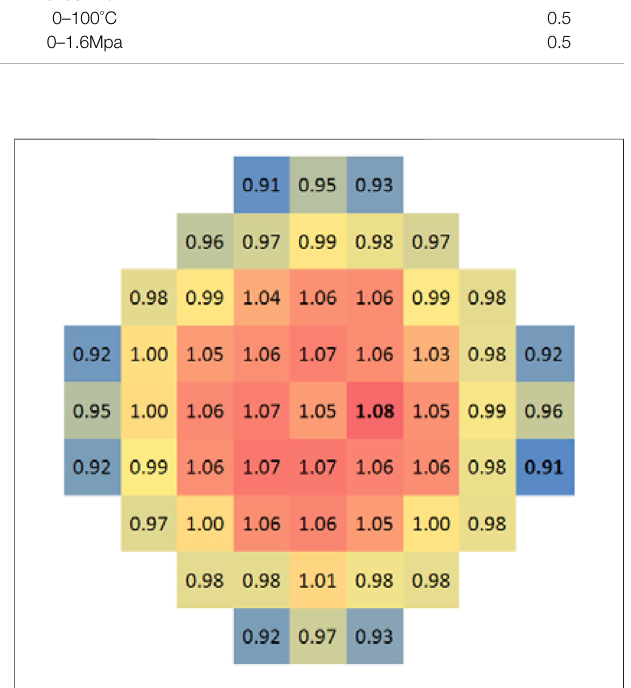
FIGURE 7 | Flow distribution map under standard